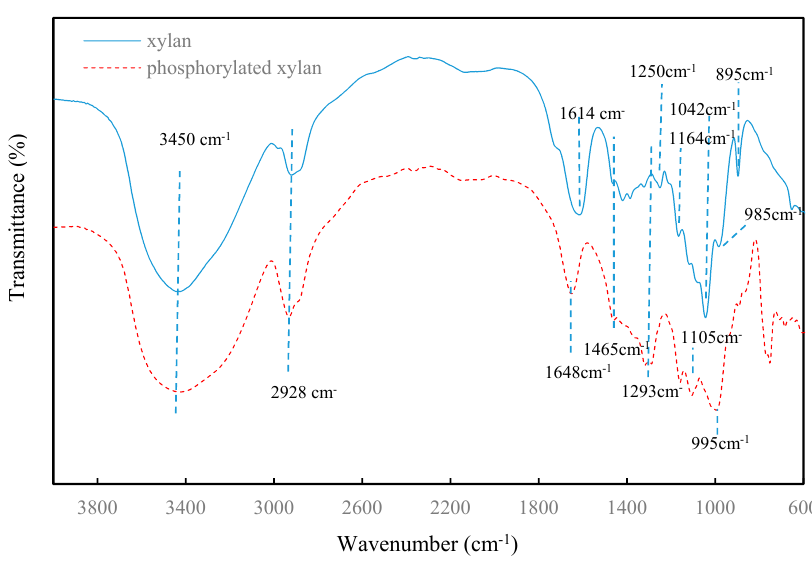
Figure 6. FTIR spectra of xylan and phosphorylated xylan.